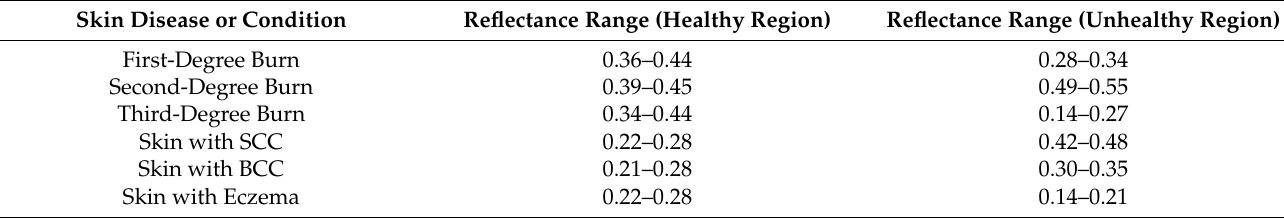
Table 2. Reflectance range for a sample of 60 participants with skin diseases or